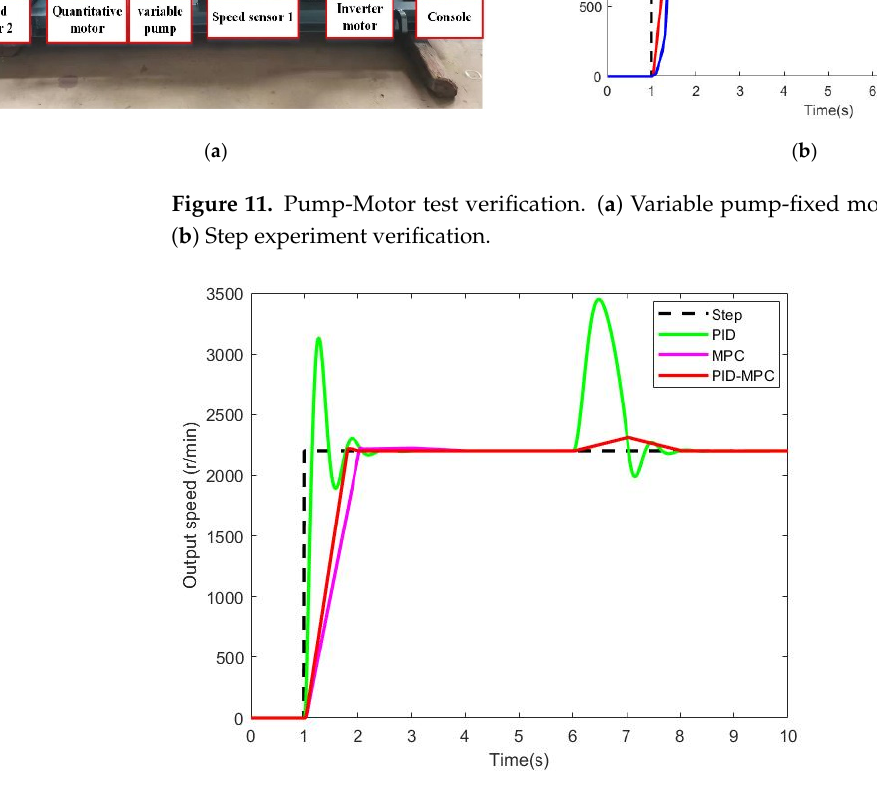
Figure 12. The change of motor control speed under step signal.